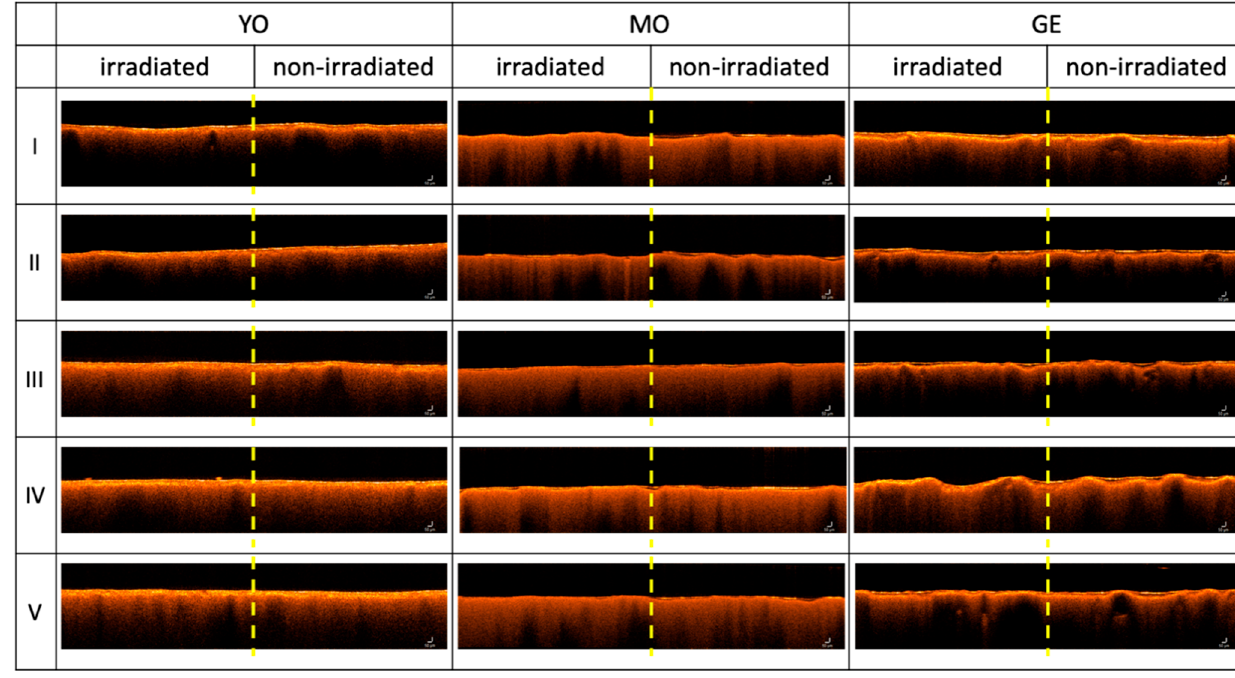
Figure 7. Cross-sectional OCT images (5 mm(x) × 1 mm(z)) as a function of I-V cleaning tests and painted layer (YO, MO, GE). The OCT depth profile images are centered and divided by the yellow dashed line to show the irradiated ( left ) and non-irradiated ( right ) portion of the samples.